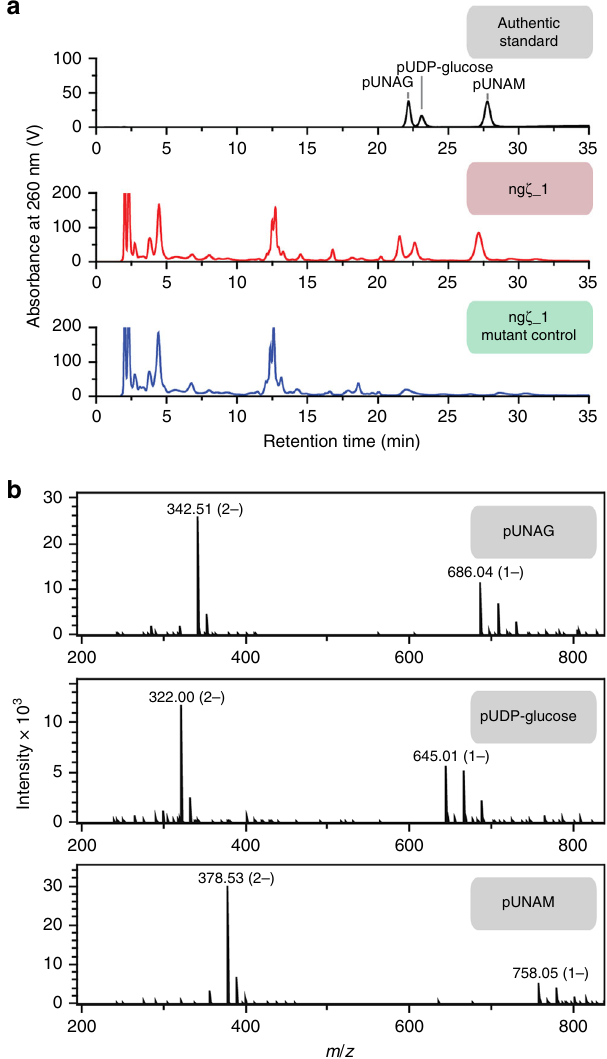
Fig. 2 Ng ζ _1 phosphorylates different UDP-activated sugar species. a High pressure liquid chromatography analysis of small metabolite extracts from E. coli strain C41(DE3) cells expressing either ng ζ _1 (red) or the inactive ng ζ _1(K115A) variant (blue). Separation of UNAG, UDP-glucose and UNAM phosphorylated by ng ζ _1 in vitro are shown for genuine standards (gray).